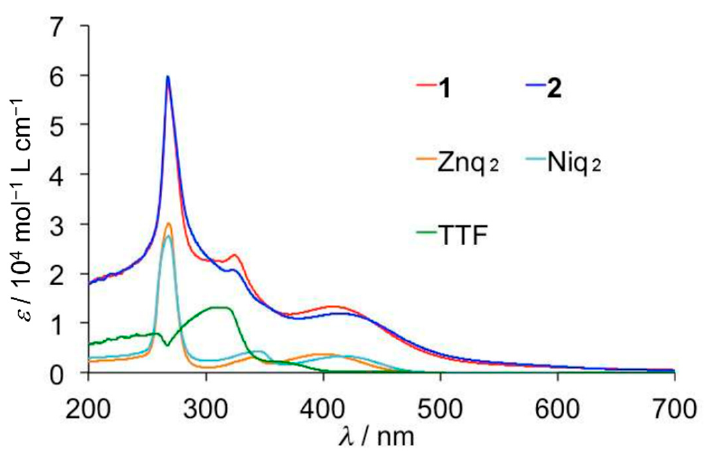
Figure 1. UV-Vis absorption spectra in 10 − 4 M DMF